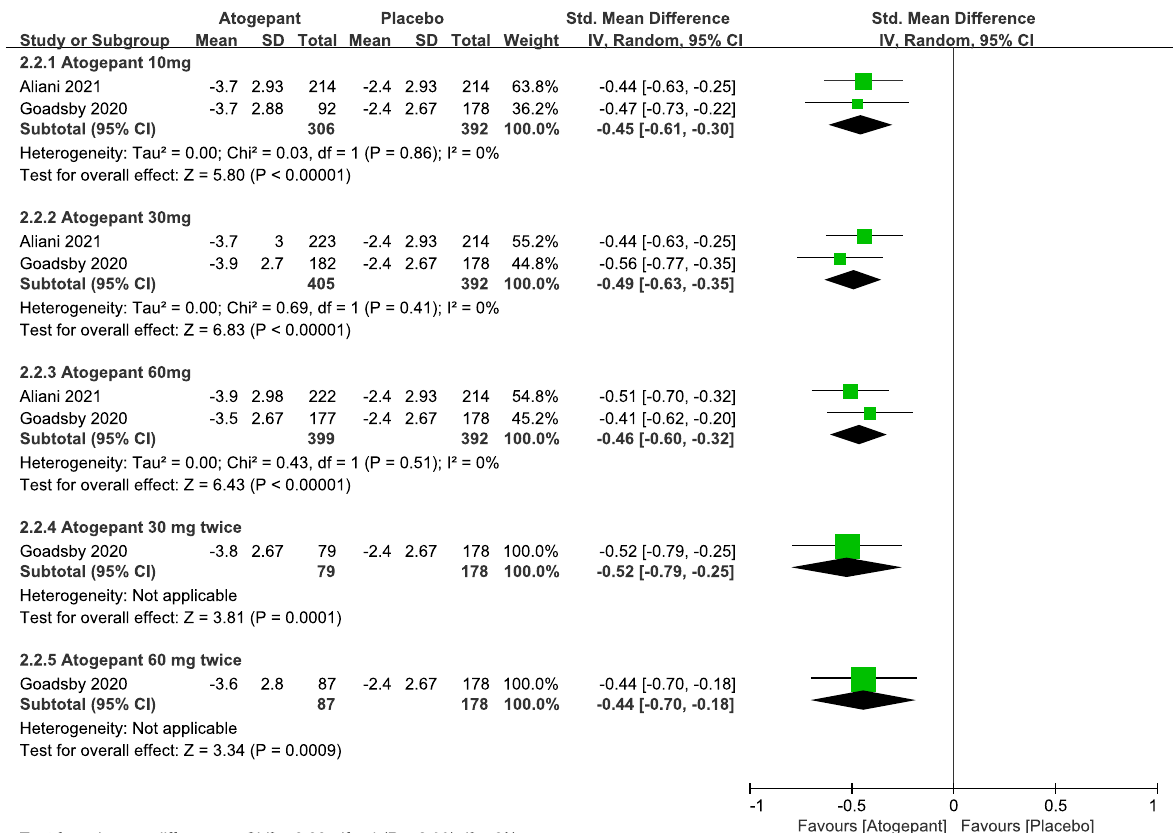
Fig. 4 The pooled SMD of monthly medication use days in different doses compared with placebo. The green square indicates the estimated SMD for each RCT. The size of green square indicates the estimated weight of each RCT, and the extending lines indicate the estimated 95% CI of SMD for each RCT. The black diamond indicates the estimated SMD (95% CI) for all patients together. CI, confidence interval; RCT, randomized controlled trial; SMD, standard mean